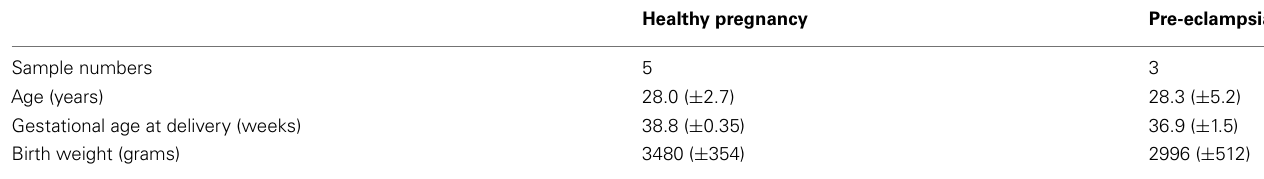
TableA2 | Patient